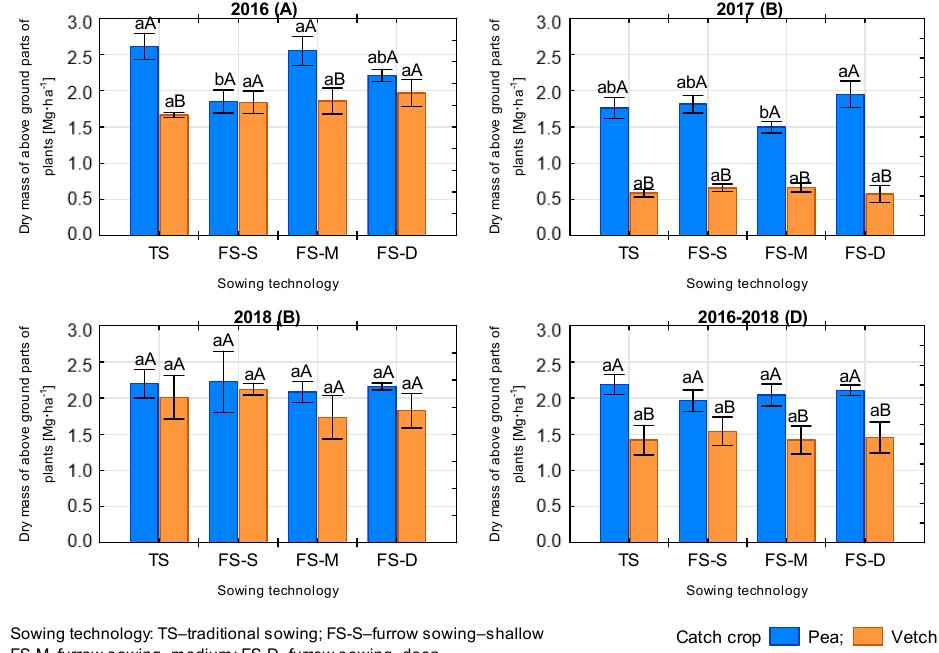
Figure 10. Yield of dry matter of aboveground parts and post-harvest residue of catch crops [Mg ha − 1 ]—average for 2016–2018. a—the same small letter for different sowing methods indicates the lack of significant differences between means ( p = 0.05). A,B—different capital letter for different crops indicates significant differences between means ( p = 0.05).